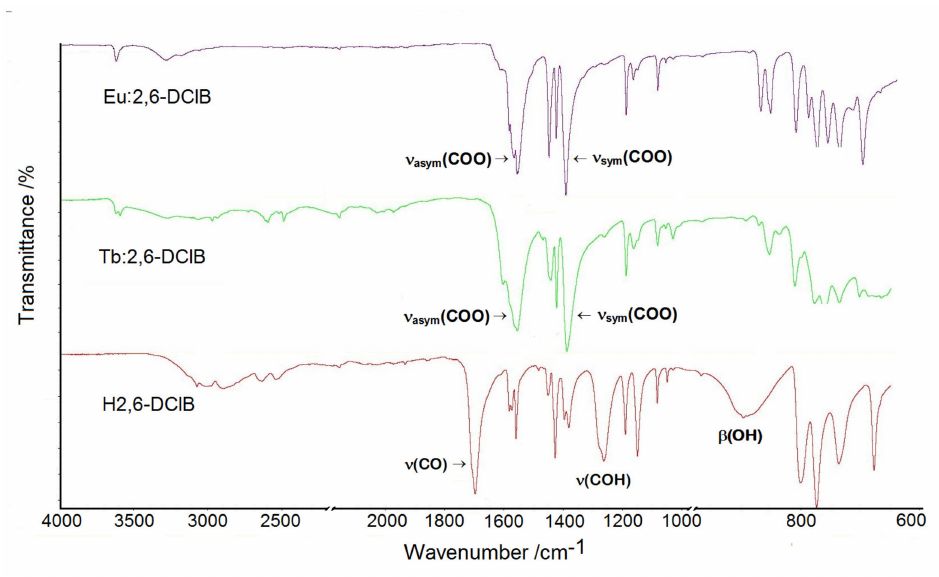
Figure 2. The ATR/FT-IR spectra of free 2,6-dichlorobenzoic acid and its complexes with Eu(III) and